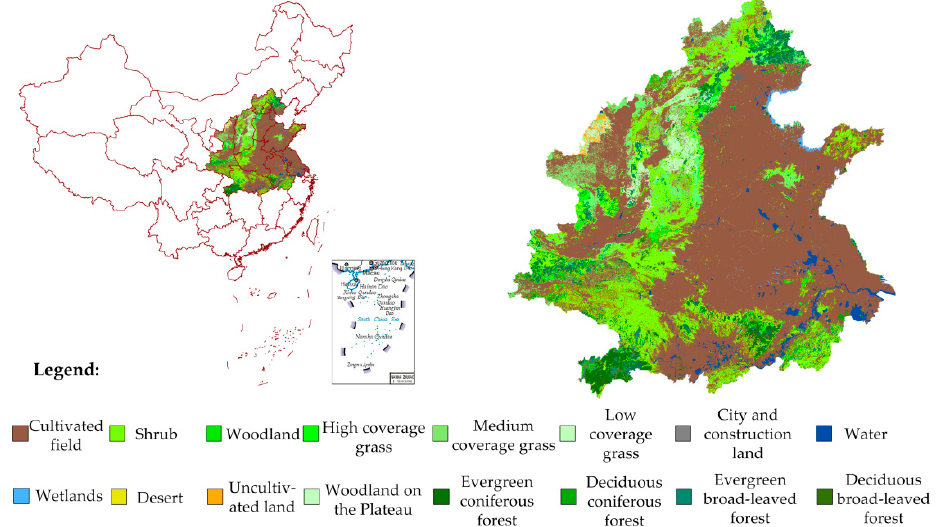
Figure 9. Vegetation coverage classification in some provinces and cities in China.